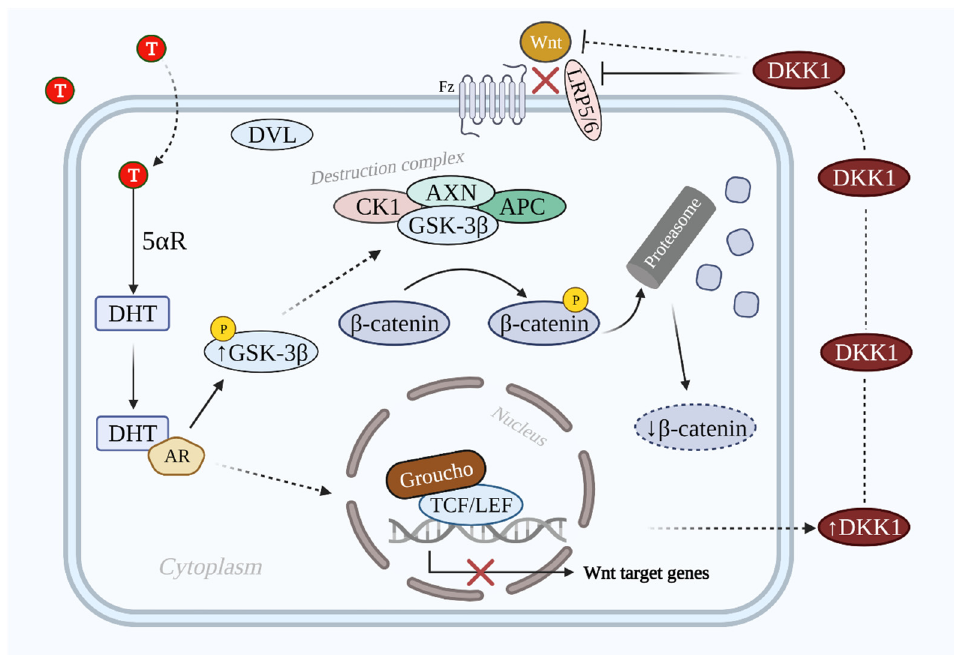
Figure 3. Illustration of Wnt/ β -catenin signaling pathway inhibition by DKK1 in AGA. In the AGA population the T level is elevated. T is converted into DHT by 5 α R, which binds to AR and prevents the dephosphorylation of GSK-3 β . GSK-3 β induces the phosphorylation of β -catenin via the destruction complex. Phosphorylated β -catenin is degraded by the proteasome. On the other hand, DKK1 is also secreted that antagonizes Wnt/ β -catenin signaling via LRP5/6 inhibition. As a result, the Wnt/ β -catenin signaling pathway is inactivated and target genes are not expressed. Abbreviations: T, testosterone; DHT, dihydrotestosterone; 5 α R, 5 alpha-reductase; AR, androgen receptor; DKK1, dickkopf-related protein 1; Wnt, wingless and integrated-1; Fz, frizzled; LRP5/6, low-density lipoprotein receptor-related proteins 5/6; GSK-3 β , glycogen synthase kinase 3 β ; CK1, casein kinase 1; DVL, dishevelled; APC, adenomatous polyposis coli; TCF/LEF, T-cell factor/lymphoid enhancer factor.